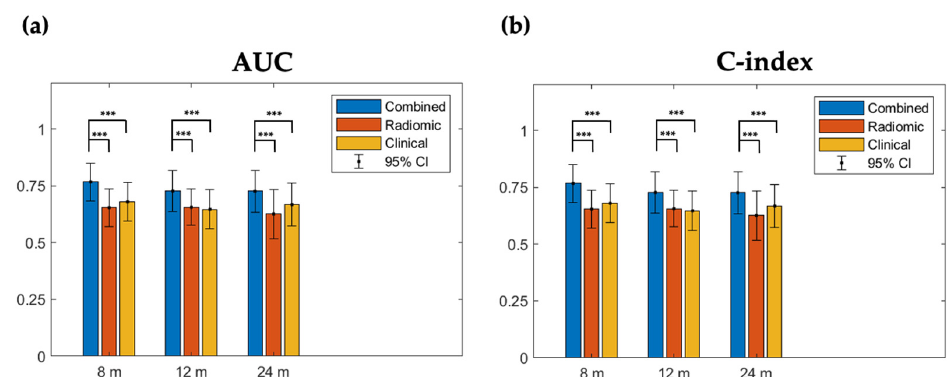
Figure 3. Comparison of model performance among the combined, radiomic, and clinical models. AUCs and C-indices based on the three optimal probabilities were evaluated with bootstrap resampling 100 times. Red, green, and blue lines correspond to C-index from the combined, radiomic, and clinical models, respectively. ( a ) AUCs in the combined model have the best performance at three time points. The combined model showed significantly higher AUCs than the other models. ( b ) C-indices in the combined model have the best performance at three time points. The combined model showed a significantly higher C-index than the other models. 95% CI: 95% confidence interval; Red: 8 months; Green: 12 months; Blue: 24 months; ***: p < 0.001.